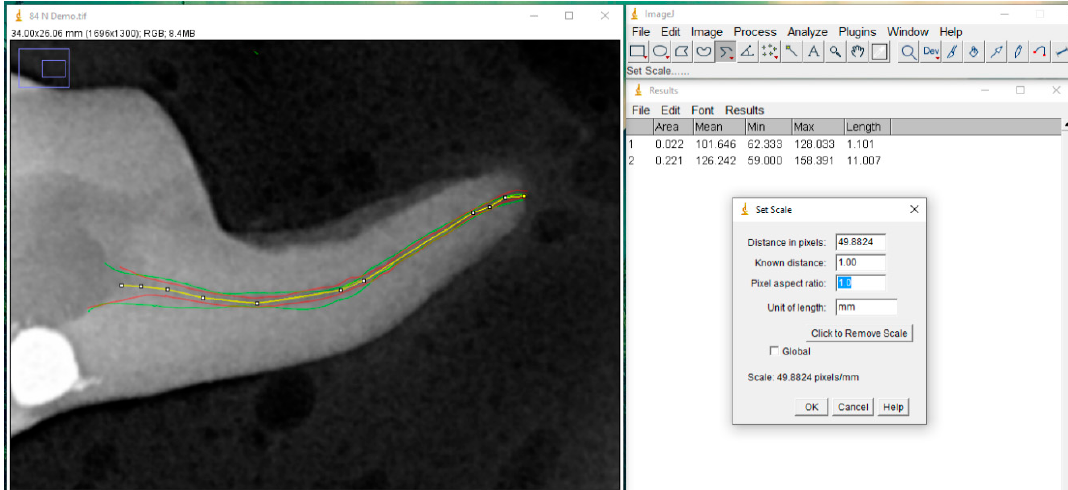
Figure 4. Measurements on periapical digital radiograph image.